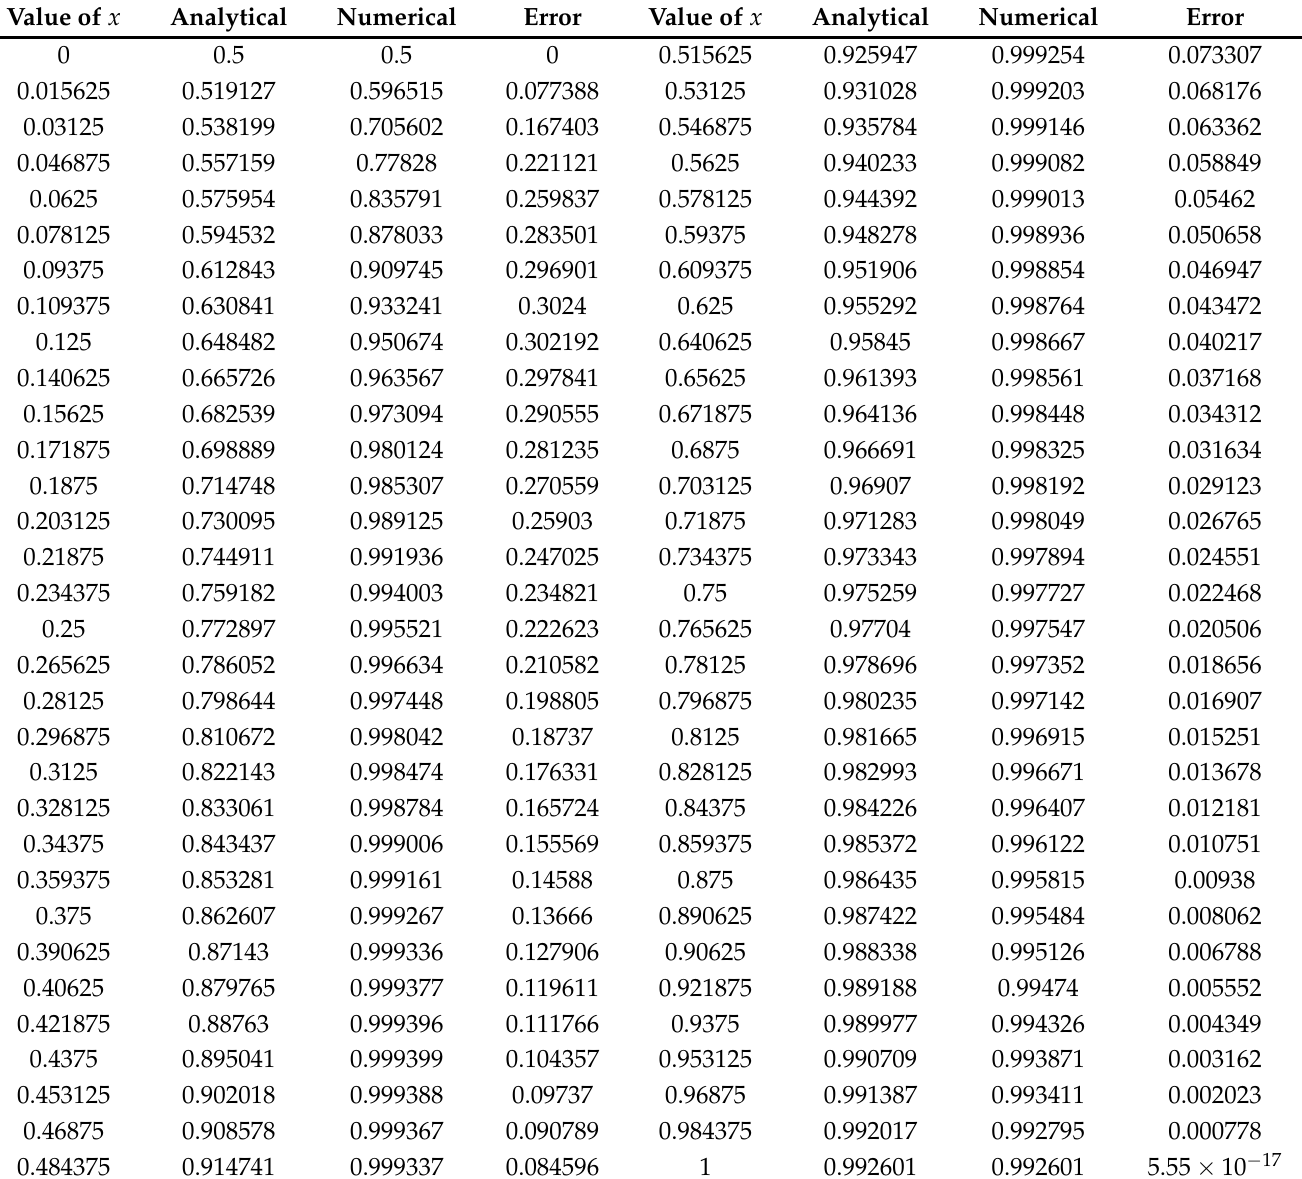
Table 1. Analytical and numerical matching through MDA and TQBS